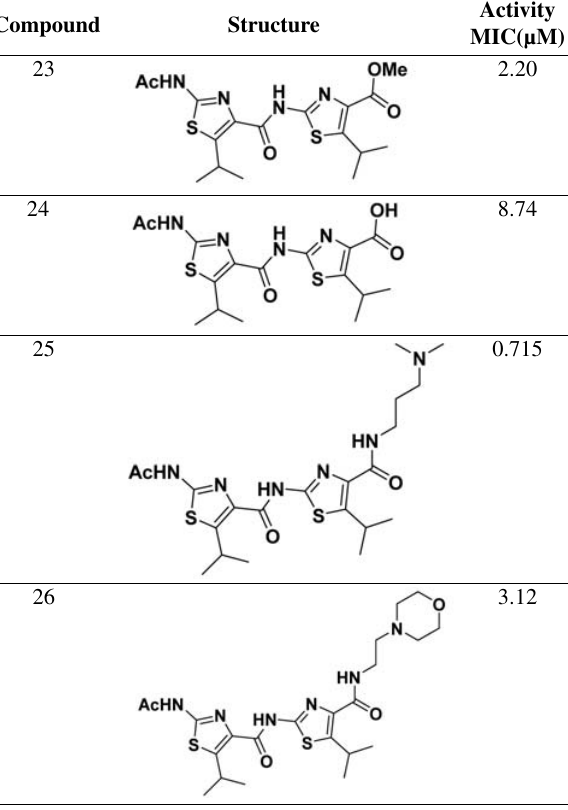
Table 2. Selected examples of anti-trypanosomal activity of hete- rocyclic oligoamide dimers (for more examples see reference 26)